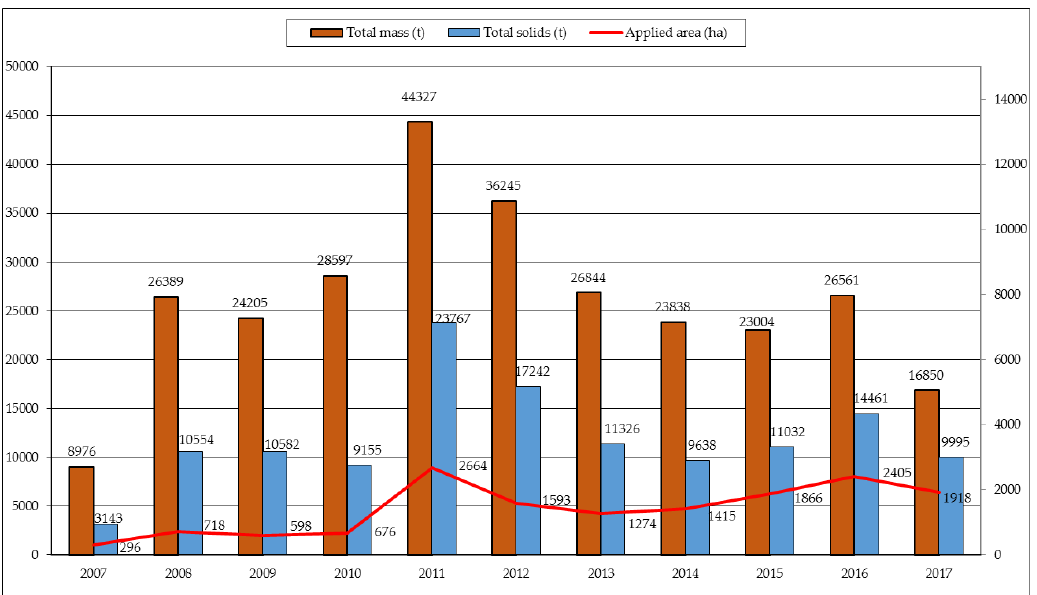
Figure 3. Mass of sewage sludge sanitized by prolonged alkaline stabilization applied to agricultural land, from 2007 to 2017 in Paraná, Brazil.